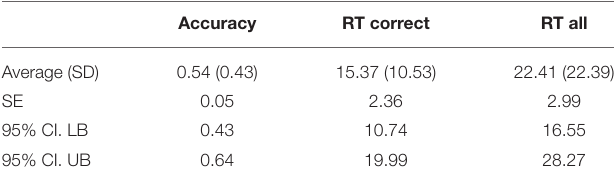
TABLE 1 | Descriptive statistics on accuracy and response times, n =